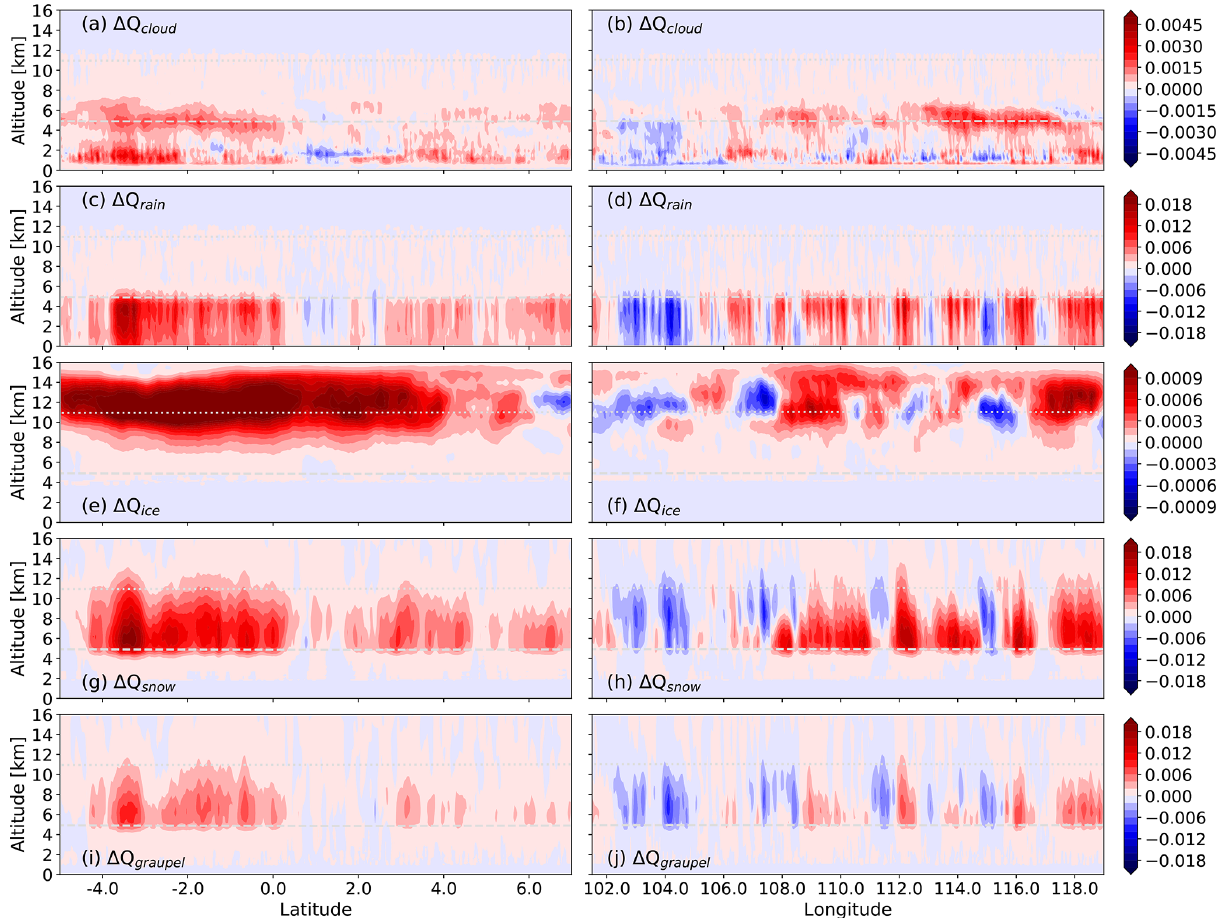
Figure A1. Same as (c, f, i, l, o) in Fig. 11 but for (a, c, e, g, i) Region 1 and (b, d, f, h, j) Region 2. Note that it is a zonal mean, rather than a meridional mean, for Region